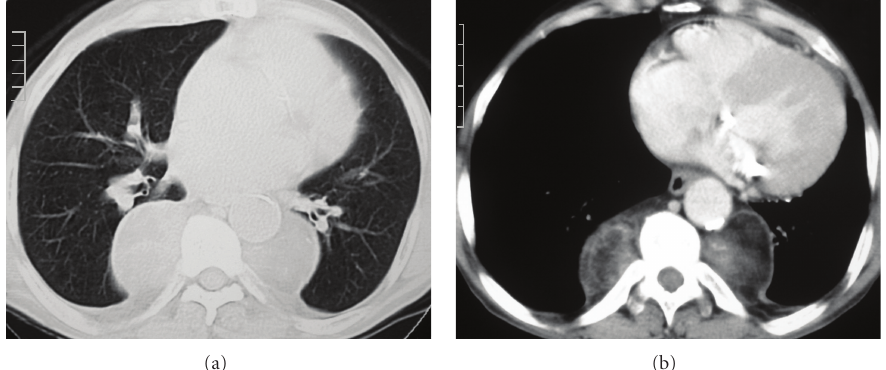
Figure 2: Computed tomography with pulmonary (a) and mediastinal (b) window settings demonstrates smooth heterogeneous (soft tissue and fat densities) bilateral masses in the paravertebral